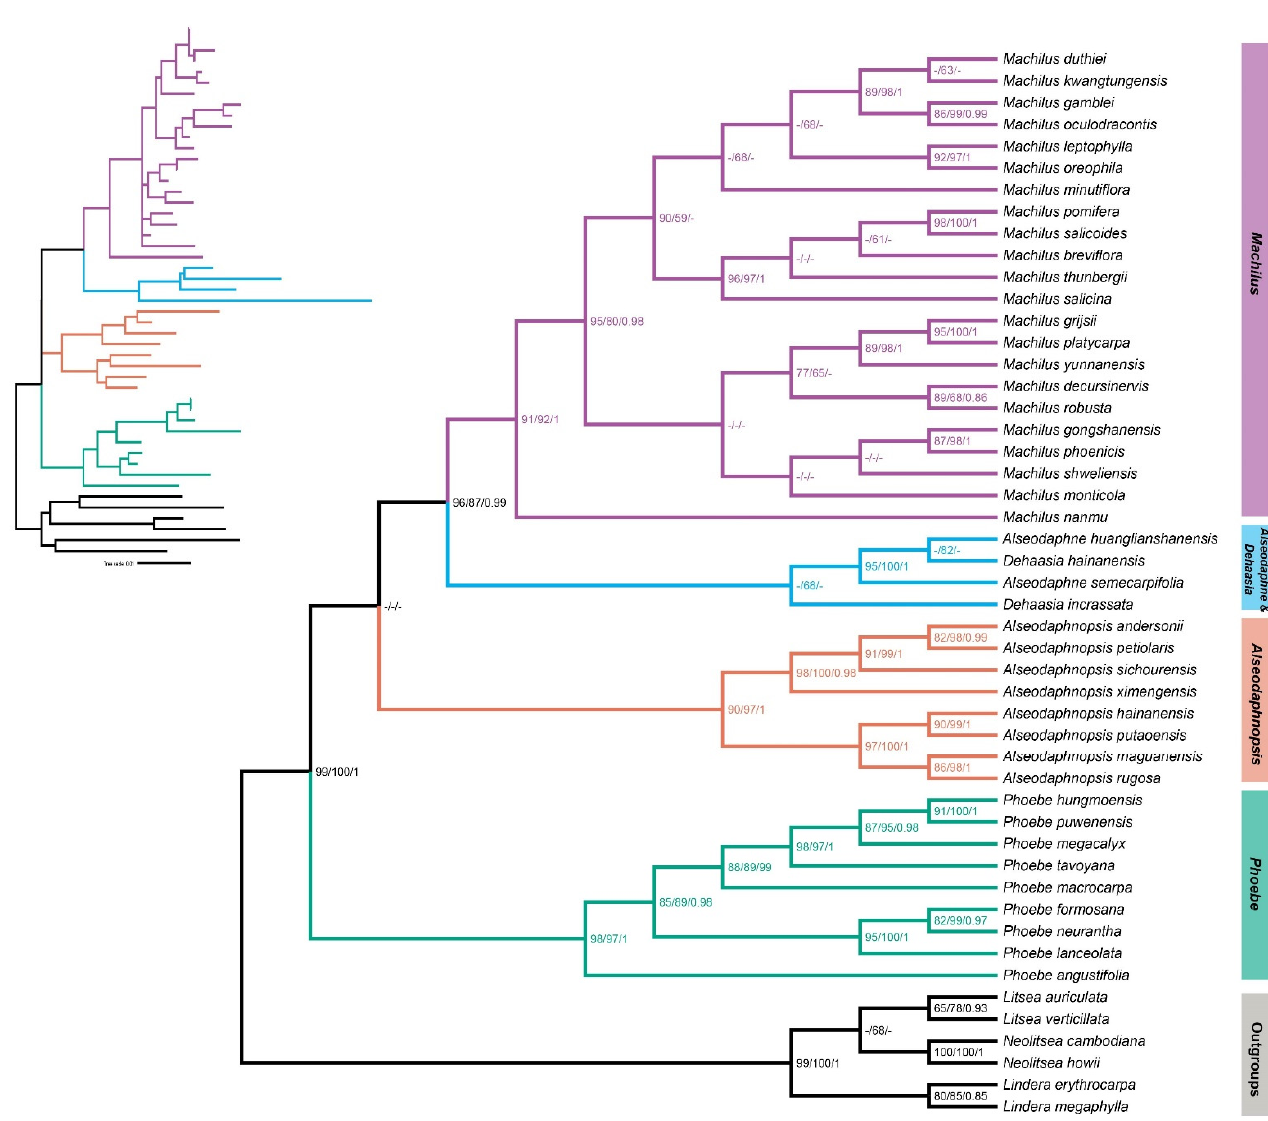
Figure 1. Maximum likelihood (ML) tree of the Persea group based on nrITS + LEAFY intron II. Numbers of nodes indicate support values of Shimodaira–Hasegawa-like approximate likelihood ratio test (SH-aLRT)/ML bootstrap support (BS)/Bayesian inference (BI) posterior probability (PP). “–” represents nodes with SH-aLRT/BS/PP support < 50%/0.8.